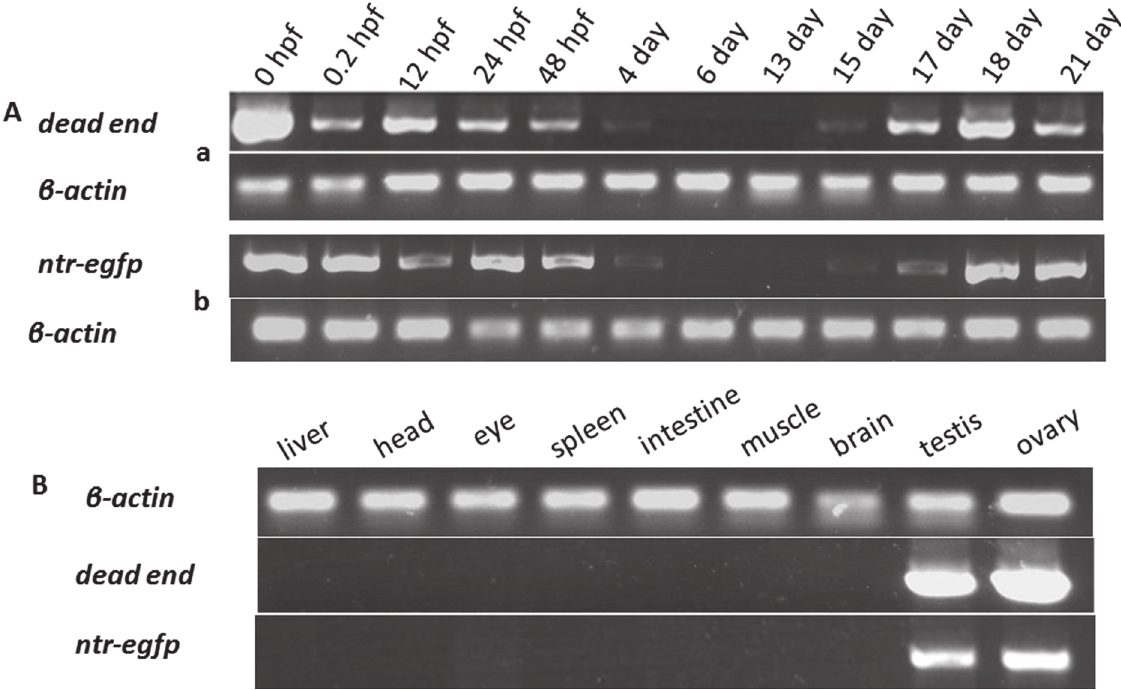
Fig 4. Detection of the transcripts of dnd and ntr-egfp transgene in transgenic fish at different developmental stages. Endogenous dnd or exogenous ntr-egfp transcript was detected using RT-PCR. A) endogenous dnd (a) or exogenous ntr-egfp (b) transcript detected in the fish body at different developmental stages. B) Endogenous dnd (middle) or exogenous ntr-egfp (bottom) transcript detected in various tissues from adult fish at 120 dpf. Transcripts of β -actin were amplified from the same samples as an internal control to test the quality of the cDNA